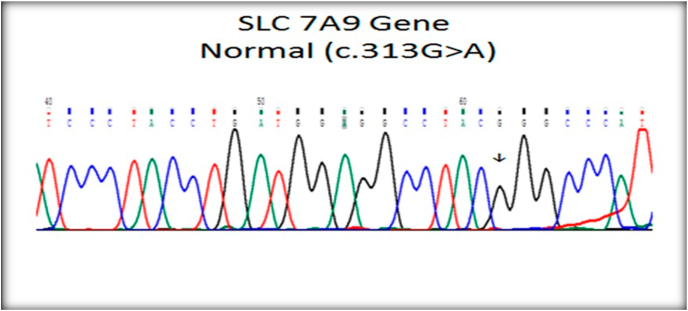
Normal SLC 7A9 gene.